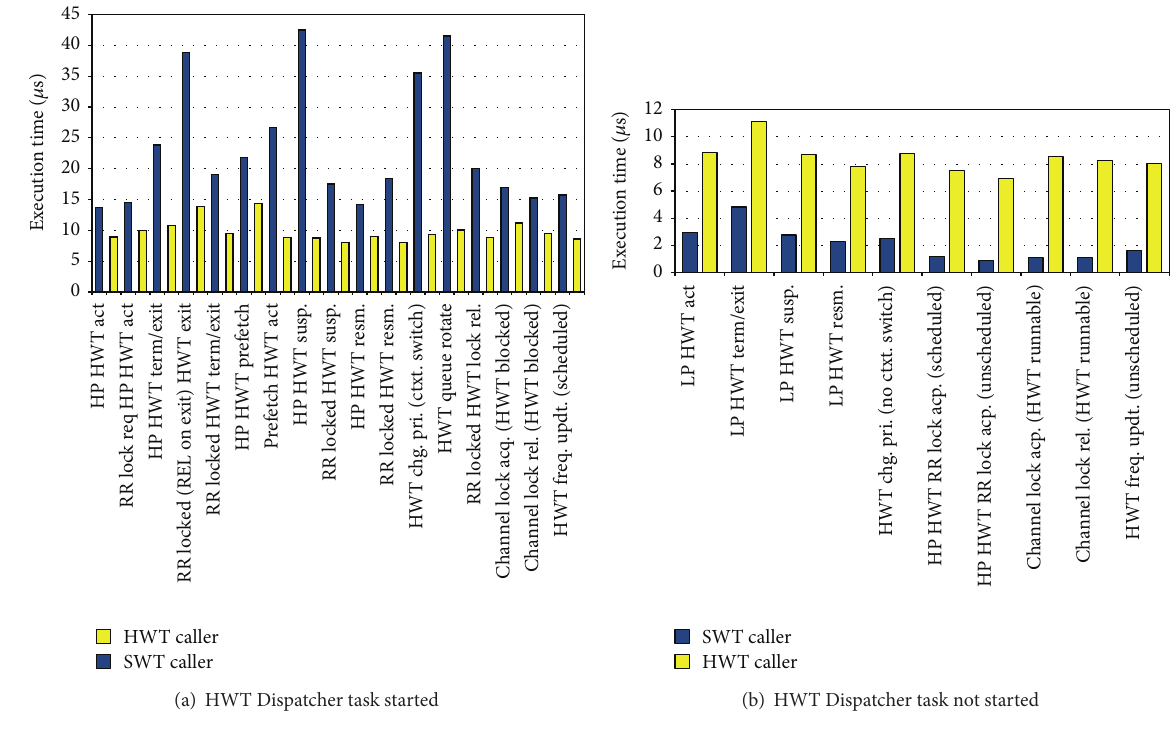
Figure 20: HWT Management API Call execution times.